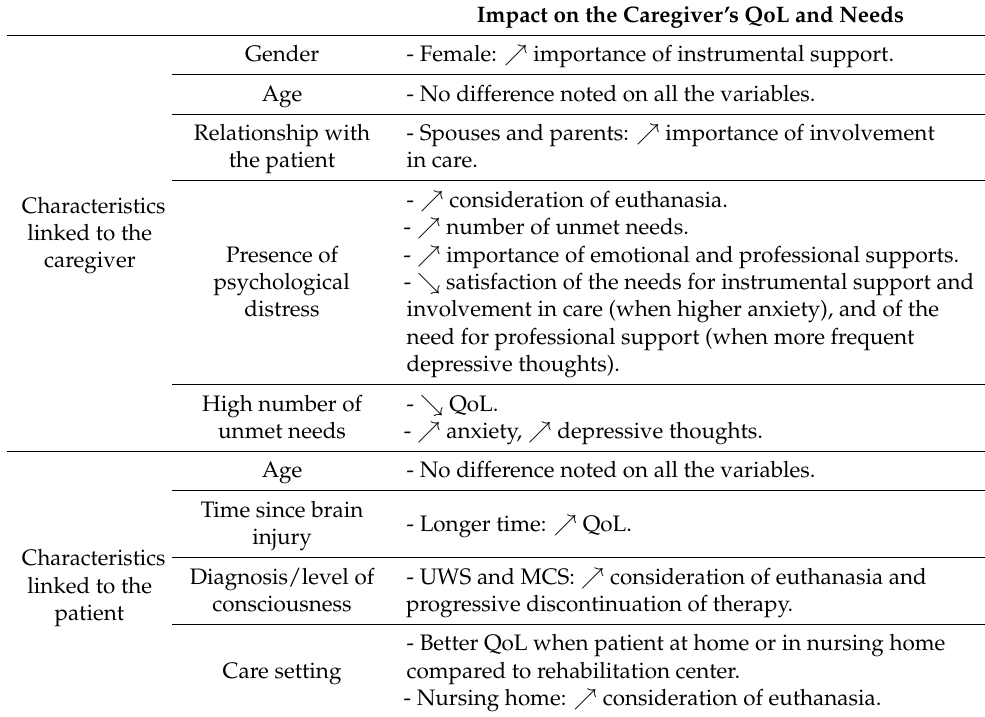
Table 5. Influence of caregiver’s and patient’s characteristics on the caregiver’s QOL and needs: summary of our